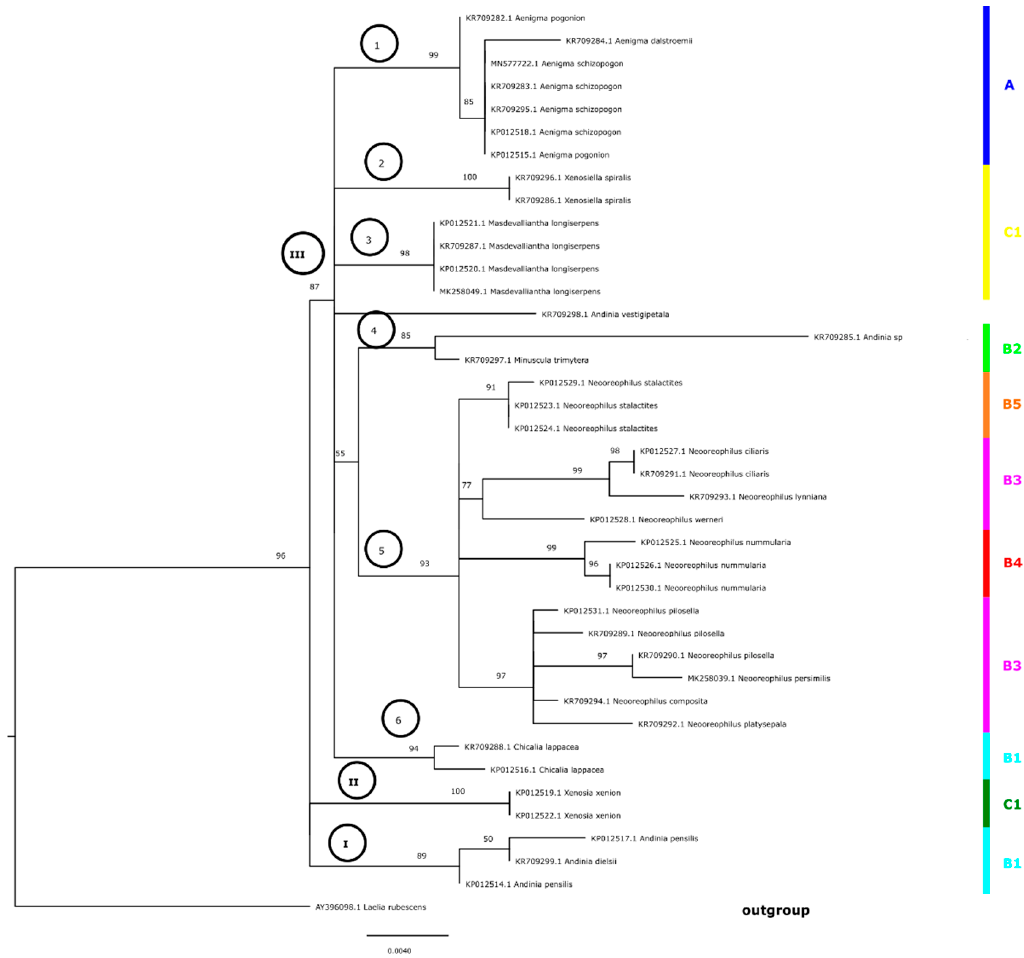
Figure 5. Phylogenetic tree performed based on maximum likelihood analysis inferred from the mat K matrix using ML/Transfer bootstrap expectation with 1000 bootstrap replicates in RaxML. Values at each node represent percent bootstrap support; bootstrap percentages less than 50% are not shown. The main and strong supported clades on the tree are marked with the numbers I–III. The subclades are tagged as 1–6. Discussed groups of species are marked as A–C1.